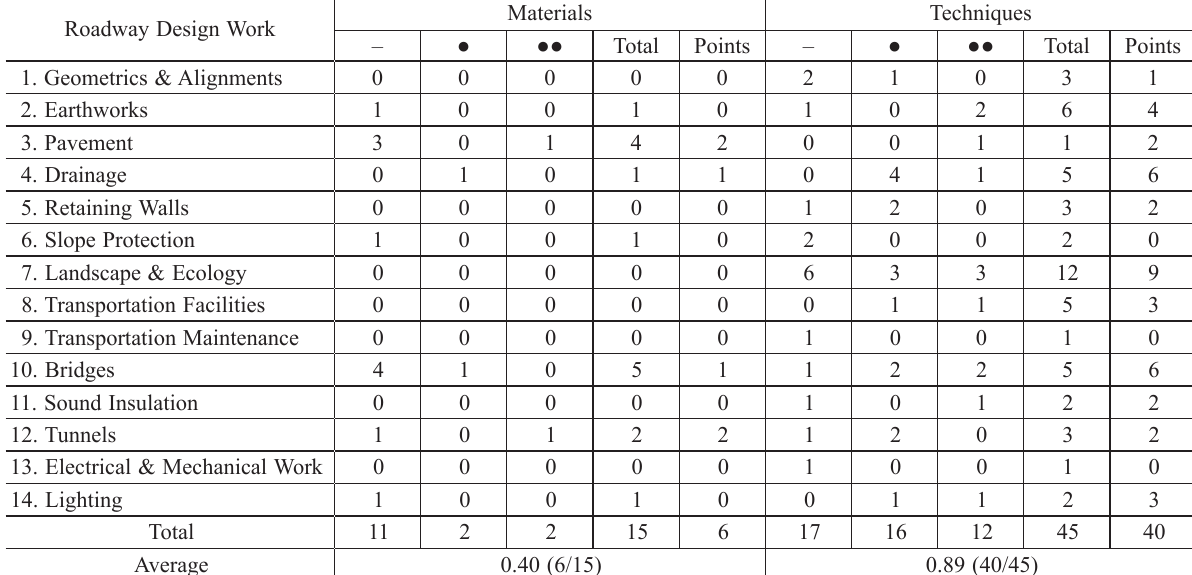
Table 4. Difficulty levels of materials and